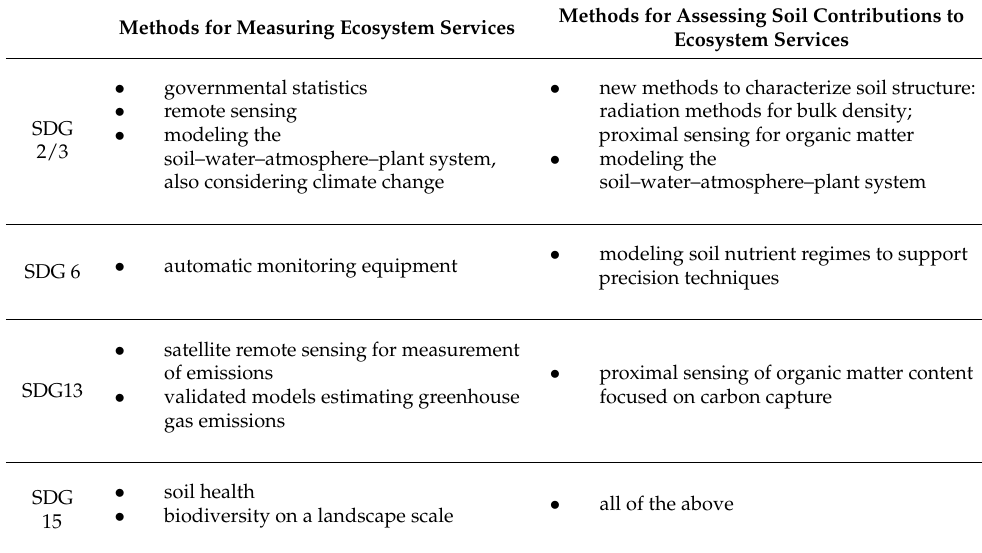
Table 3. Summary of methods to be used for characterizing ecosystem services in line with the SDGs and the Green Deal and the contributions of soil health, as discussed in this